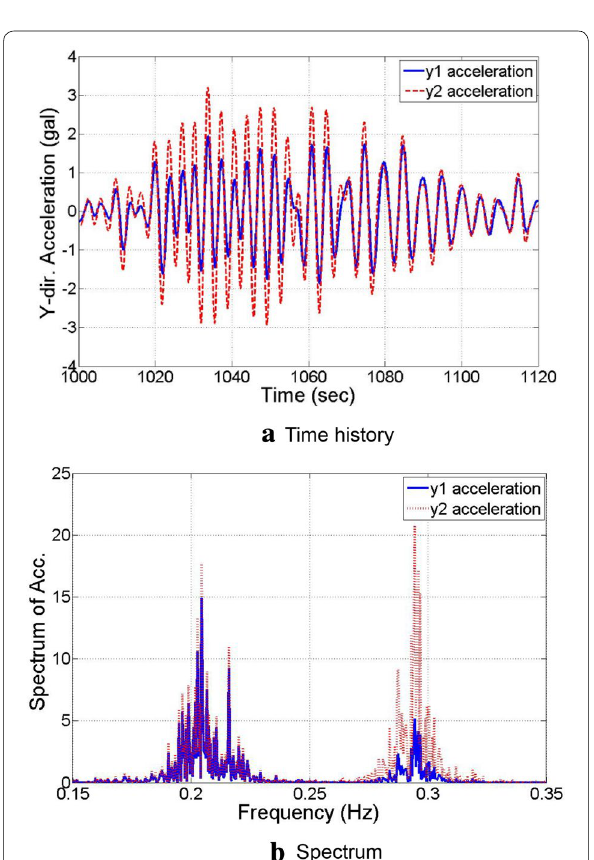
Fig. 13 Wind induced accelerations in Y direction.